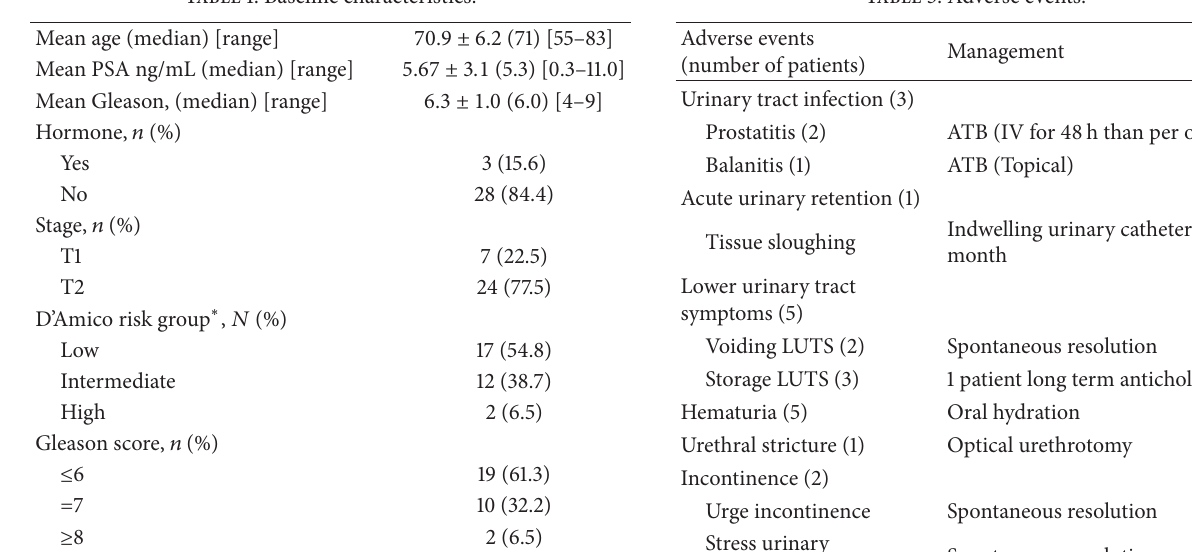
Table 1: Baseline characteristics.